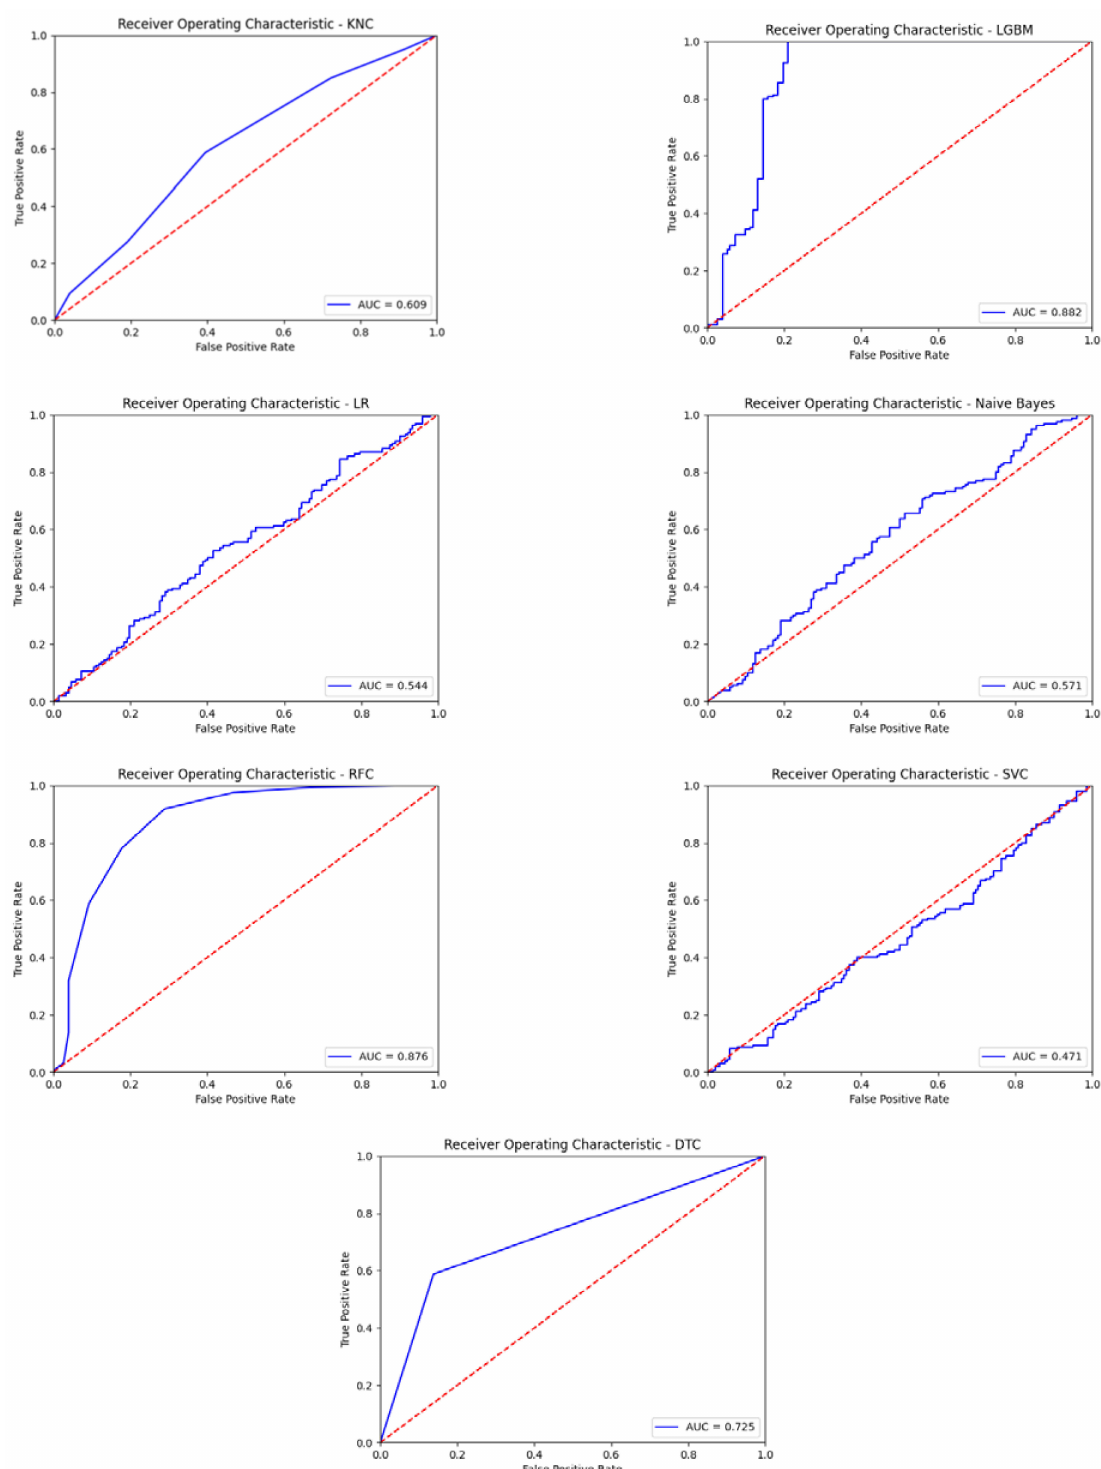
Figure 11. The obtained ROC curves with seven different classification algorithms using the first eight channels EEG